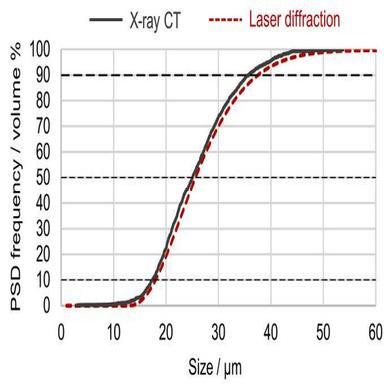
Cumulative PSD curves obtained with CT and LD in the case of CuCrZr powder.